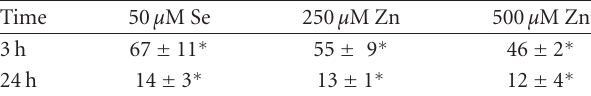
H2DCFDASe Figure 4: Action of cyclosporine A on changes in intracellular ROS formation produced by high Zn 2+ and selenite in AS-30D cells. (a) Se: 50 µ M; 3 h; (b) Zn: 250 µ M; 24 h. The cells were cultivated in RPMI 1640 medium without (control) or with the indicated concentration (in µ M) of selenite and Zn 2+ for 3 h and 24 h, respectively, in the absence or presence of 1 µ M CsA. The overall ROS production was calculated as the geometric mean of total green fluorescence of the oxidation product of DCFH 2 and is indicated in the upper right corner of each panel; for other details, see Section 2. A typical experiment out of at least three independent ones for each compound is shown. Table 2: E ff ects of high concentrations of Zn 2+ and selenite on mitochondrial transmembrane potential of AS-30D cells monitored by flow cytometry after staining the cells with the lipophilic cationic probe JC-1. The percentage of cells with red JC-1 fluorescence, reflecting high ΔΨ mito (expressed in % to the corresponding control), is presented; the percentage of cells with high ΔΨ mito in untreated control is accepted as 100%. Mean ± SE ; n = 3 independent experiments; ∗ P < 0.05 compared to untreated